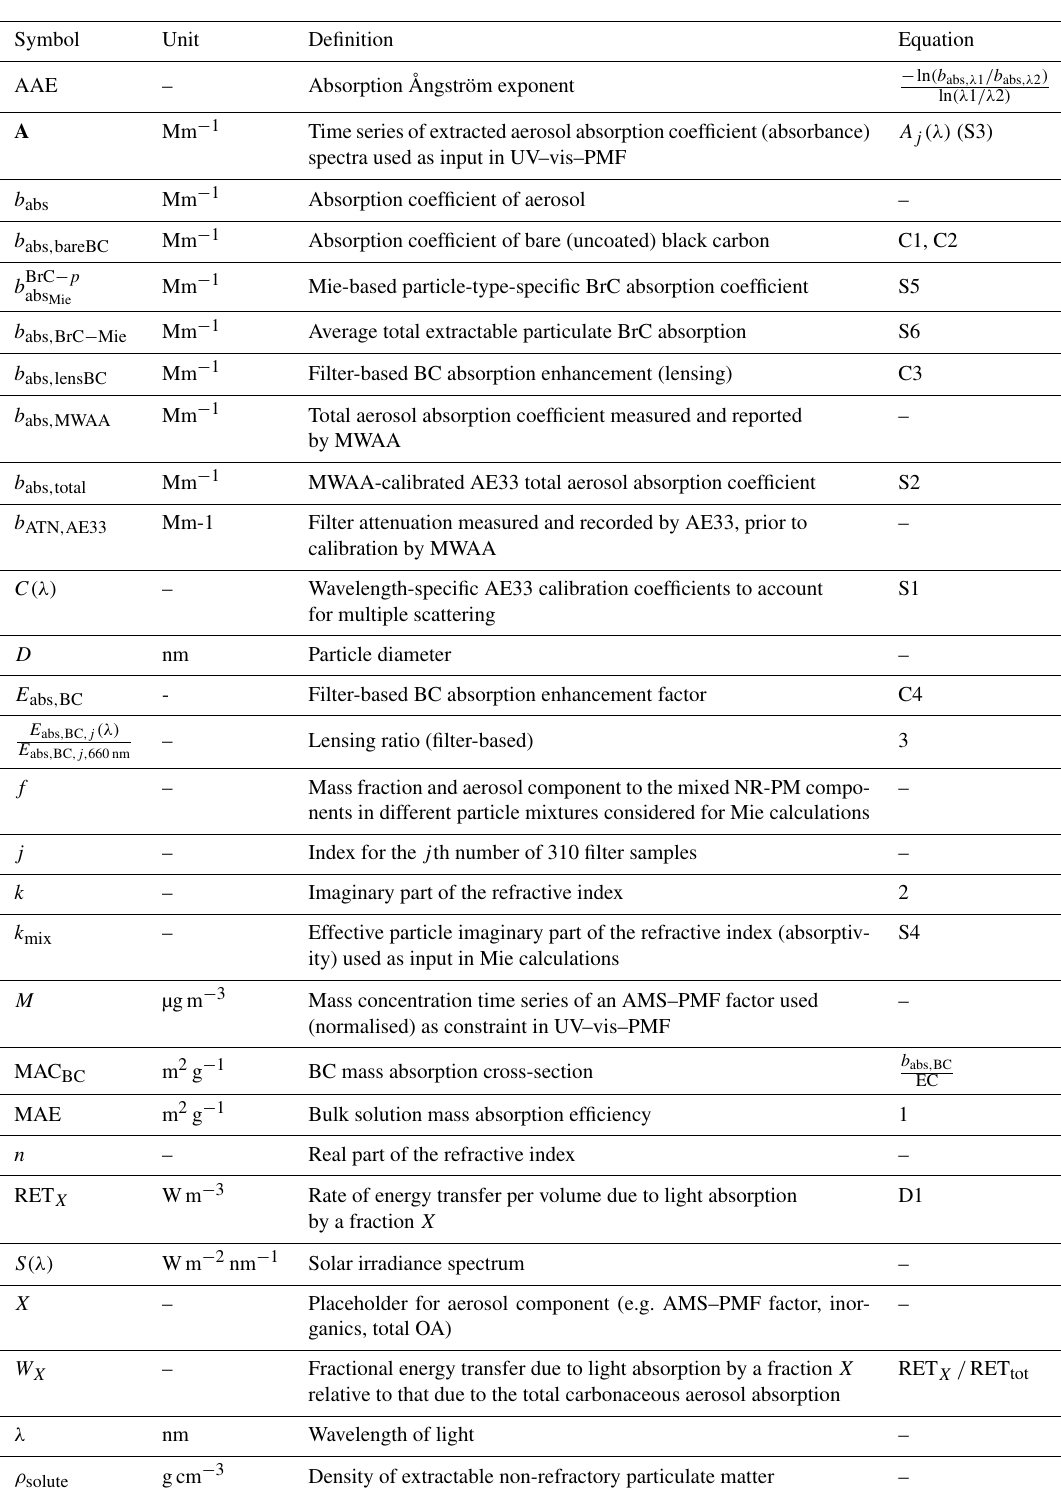
Table F1. List of symbols, units and